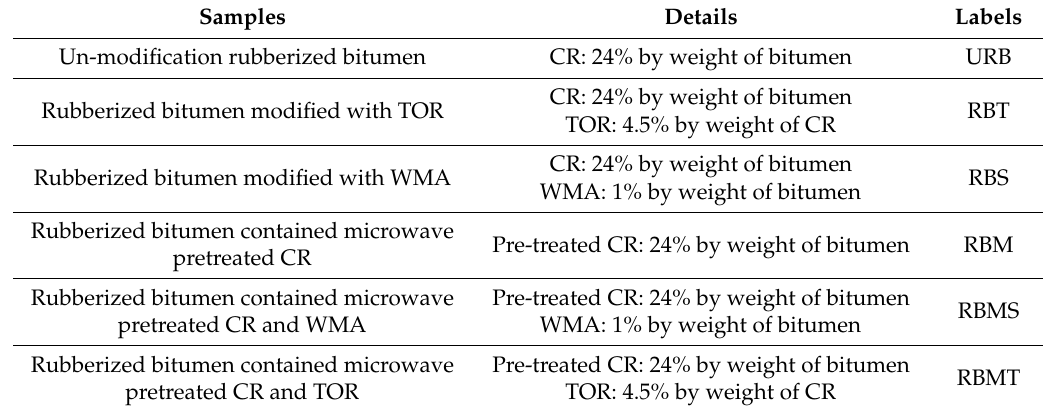
Table 2. Details and labels of di ff erent rubberized bitumen samples.